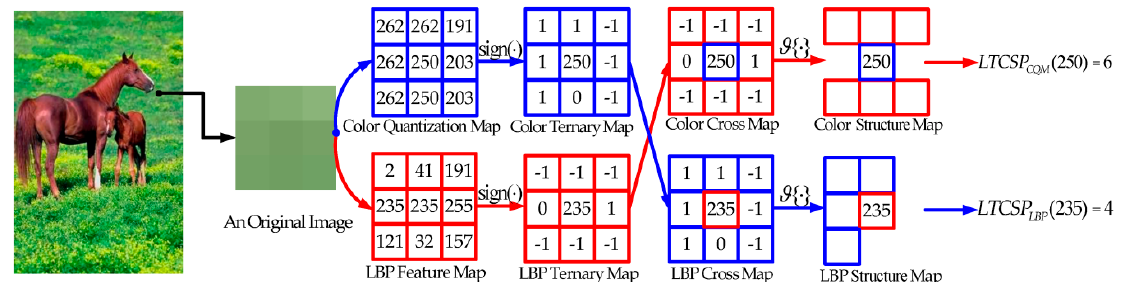
Figure 4. Schematic diagram of the local ternary cross structure pattern (LTCSP).